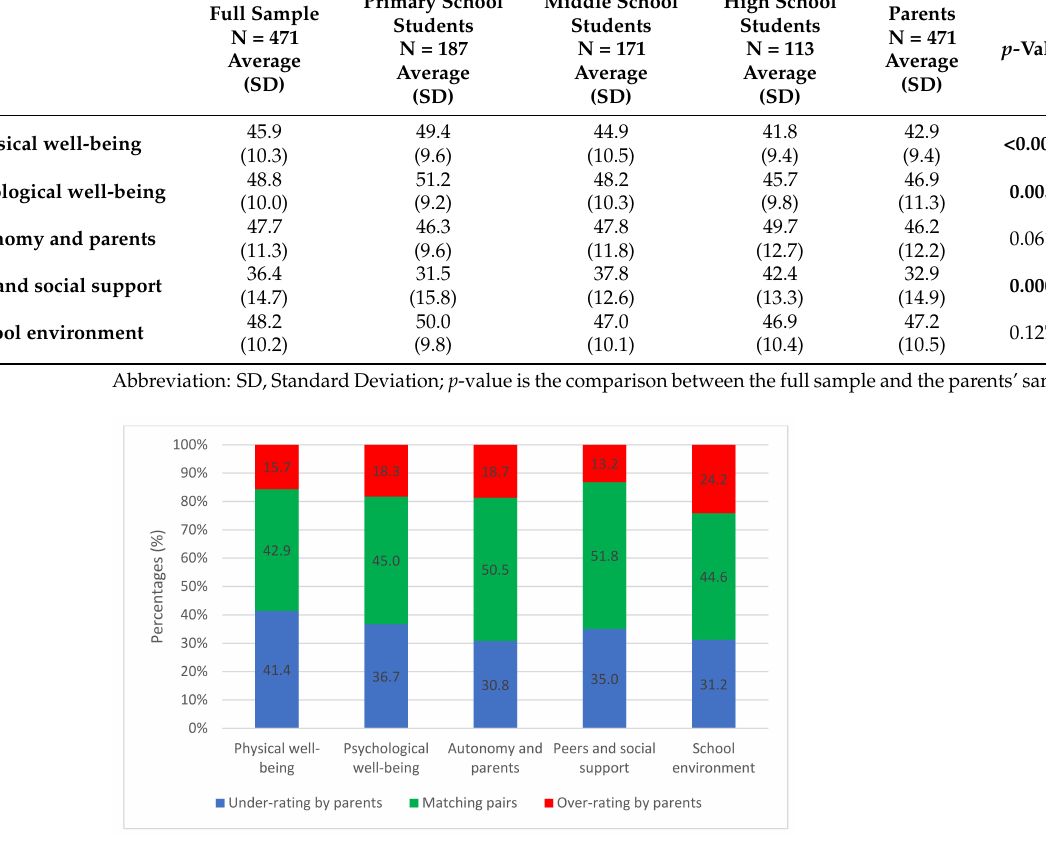
Figure 1. Distribution of matching and mismatching pairs in the different dimensions of the